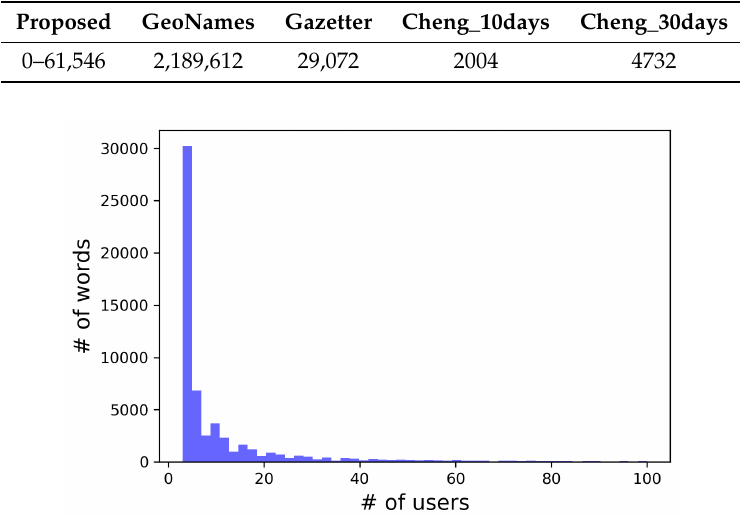
Figure 12. Number of extracted local words. A part of them are also in GeoNames. Table 3. Numbers of local words in geographic dictionaries.